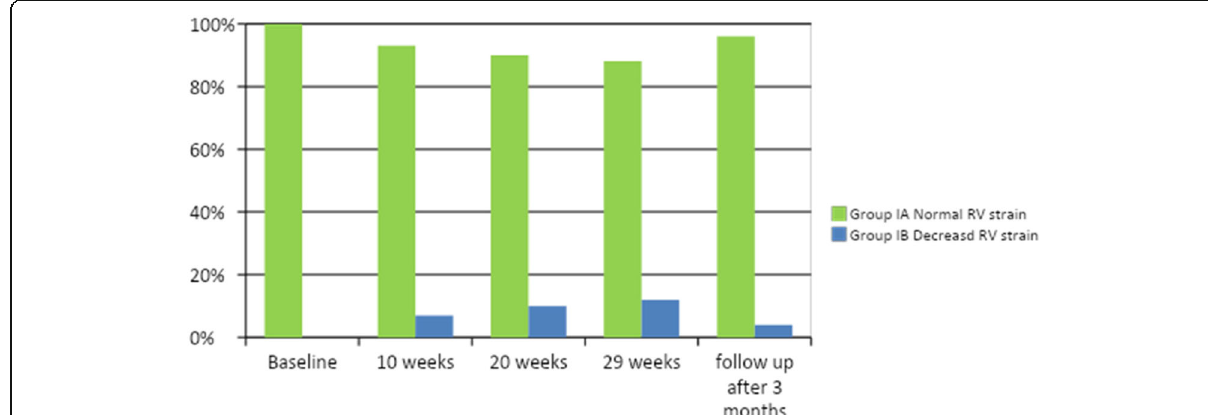
Fig. 1 Percentage of patients with osteosarcoma with normal and decreased right ventricular global longitudinal strain in group 1 subgroups before, during and after recovery of chemotherapy